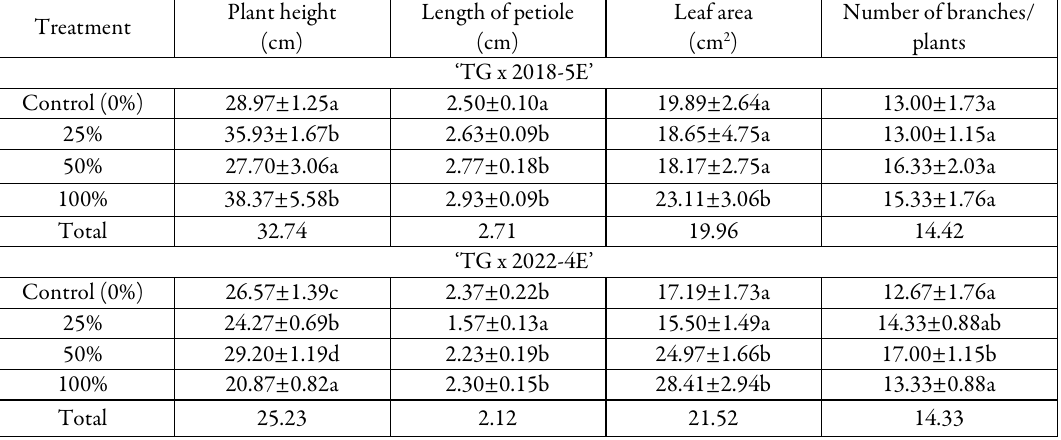
Table 1. Effects of Datura aqueous seed extracts on morphological traits of soybean varieties at maturity Plant height Length of petiole Leaf area Number of branches/ Treatment (cm) (cm) (cm 2 ) plants ‘TG x 2018-5E’ Control (0%) 28.97±1.25a 2.50±0.10a 19.89±2.64a 13.00±1.73a 25% 35.93±1.67b 2.63±0.09b 18.65±4.75a 13.00±1.15a 50% 27.70±3.06a 2.77±0.18b 18.17±2.75a 16.33±2.03a 100% 38.37±5.58b 2.93±0.09b 23.11±3.06b 15.33±1.76a Total 32.74 2.71 19.96 14.42 ‘TG x 2022-4E’ Control (0%) 26.57±1.39c 2.37±0.22b 17.19±1.73a 12.67±1.76a 25% 24.27±0.69b 1.57±0.13a 15.50±1.49a 14.33±0.88ab 50% 29.20±1.19d 2.23±0.19b 24.97±1.66b 17.00±1.15b 100% 20.87±0.82a 2.30±0.15b 28.41±2.94b 13.33±0.88a Total 25.23 2.12 21.52